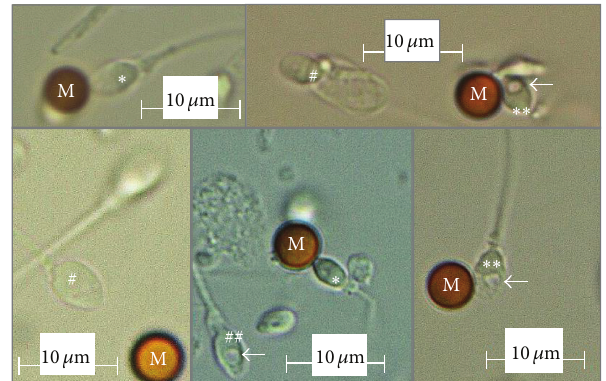
Figure 1: High-magnification observation of a sperm head ( ×